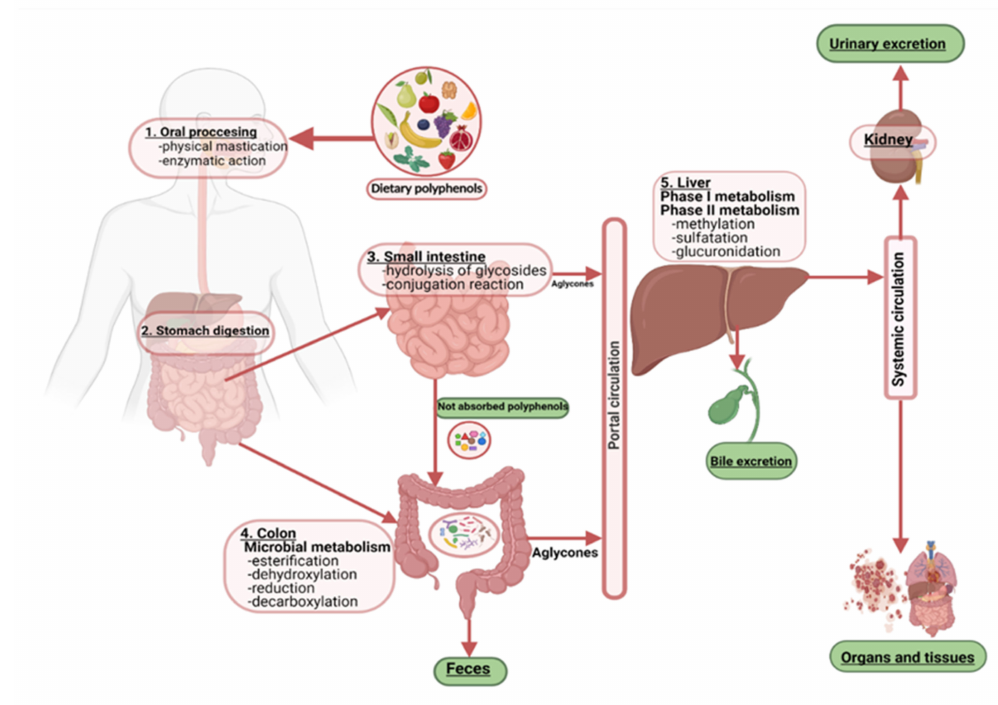
Figure 3. Metabolism of polyphenols by human gut